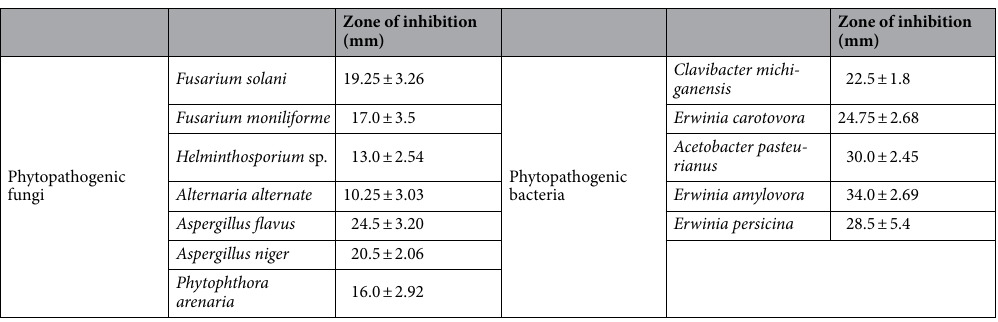
Table 1. Antimicrobial efficacy of the biogenic synthesized MnO NPs using some phytopathogenic fungi and bacteria.